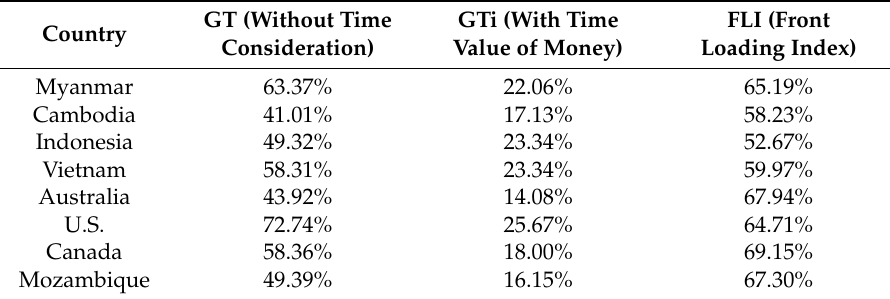
Table 7. Results of GT, GTi, and